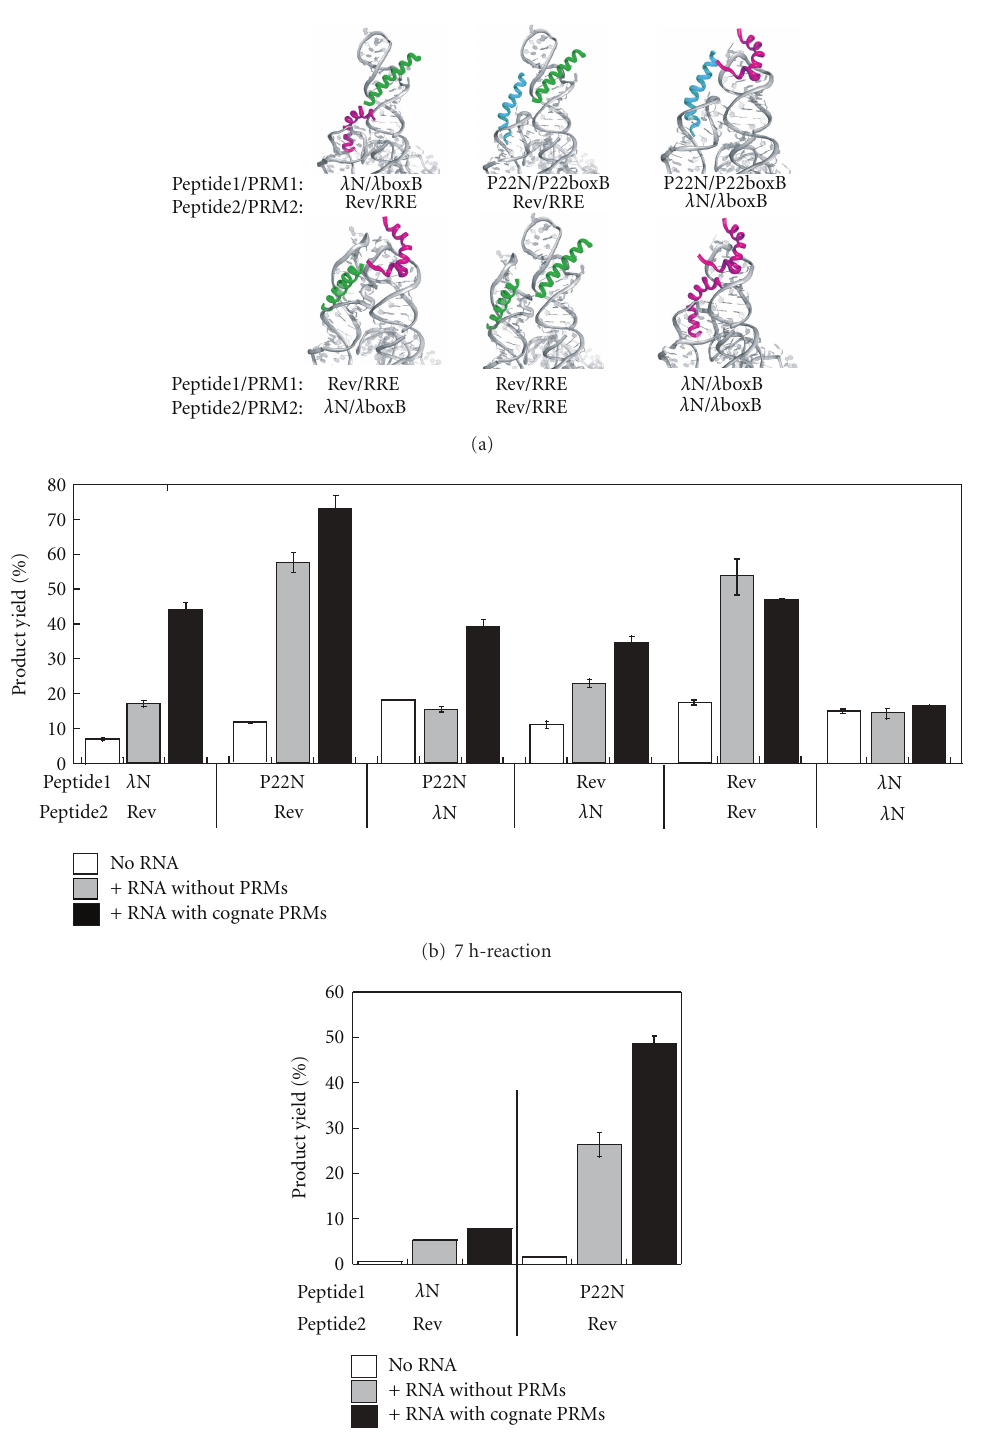
Figure 4: Chemical ligation of six sets the substrate pairings in the presence of their cognate RNA templates. (a) 3D models of peptide recognition modules in substrate-template RNP complexes. RNA elements including PRM-1 and -2 are indicated in gray. Substrate peptides were indicated in red ( λ N-peptide), green (rev-peptide), and blue (P22N-peptide), respectively. (b and c) Product yields of 7-h chemical ligation (with 7.5 μ M each peptide) in the presence of 10mM Mg 2+ ions. Reactions of the substrate peptides in the absence of template RNA are shown by white bars. Reactions in the presence of RNA templates having PRMs and lacking PRMs are shown by black and gray bars, respectively. (c) Product yields of 1-h chemical ligation (with 7.5 μ M each peptide) in the presence of 10 mM Mg 2+ ions. Reactions without RNA are shown by white bars. Reactions with RNA templates having PRMs and lacking PRMs are shown by black and gray bars,